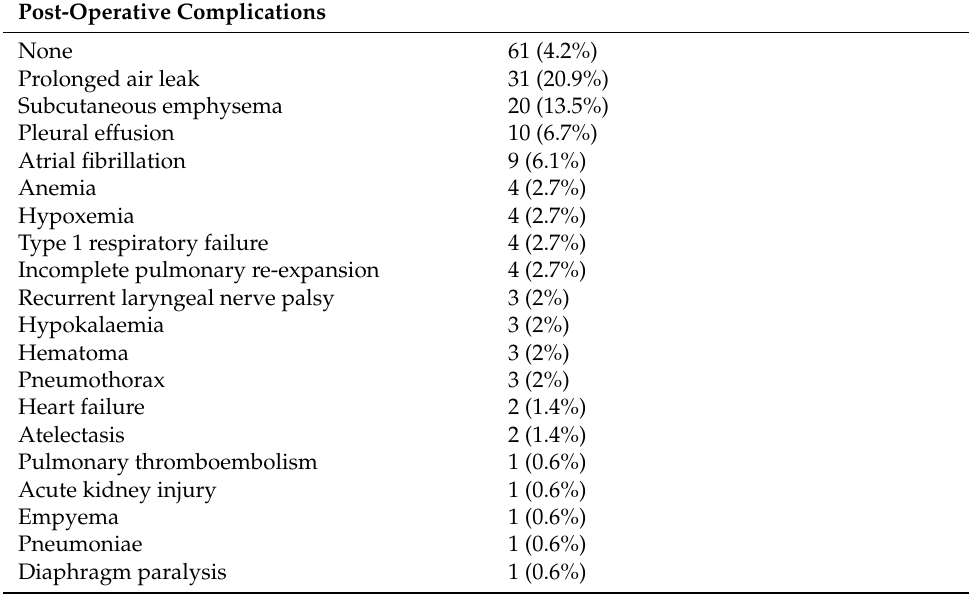
Table 3. Post-operative complications after robotic lung resection for lung cancer in high-risk